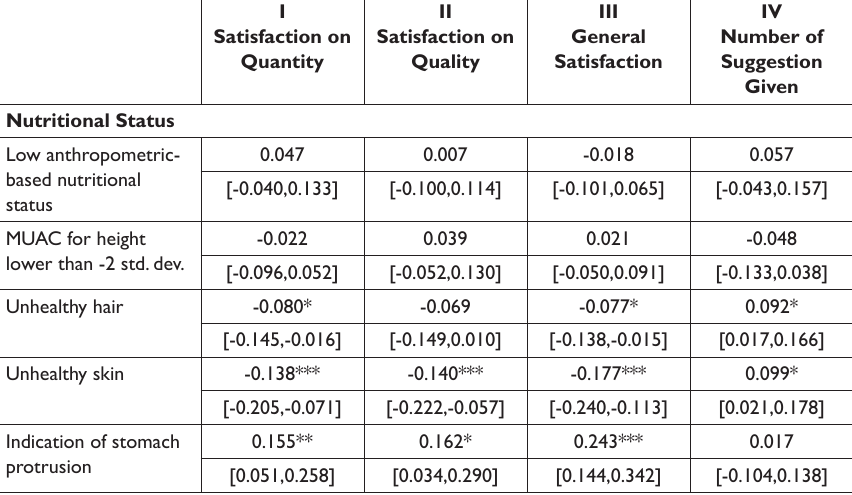
Table 1: Regression analysis on students’ satisfaction and number of